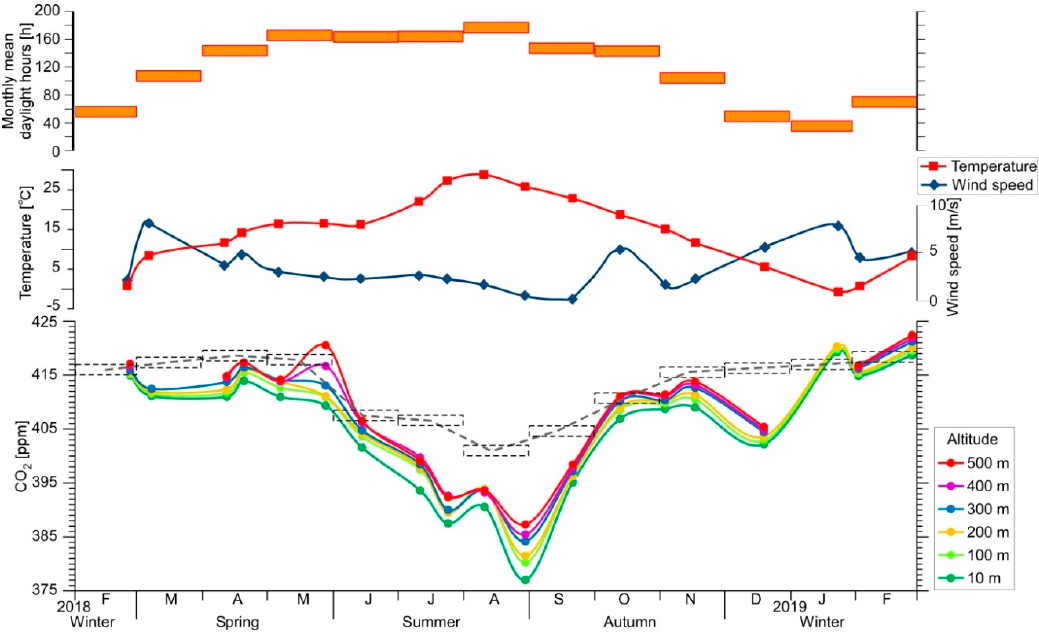
Figure 6. Monthly mean daylight hours at Ogata (40°0.0’ N, 139°57.0’ E) (top), air temperature at 1.5 m altitude and wind speed at 10 m altitude at Ogata (middle), and seasonal variations of CO 2 concentrations at each measurement altitude (bottom) from winter 2018 to winter 2019. The dashed line shows secular CO 2 concentration changes in the ground surface at Ogata (40° N, 140° E) based on the simulation by GSAM-TM [33].